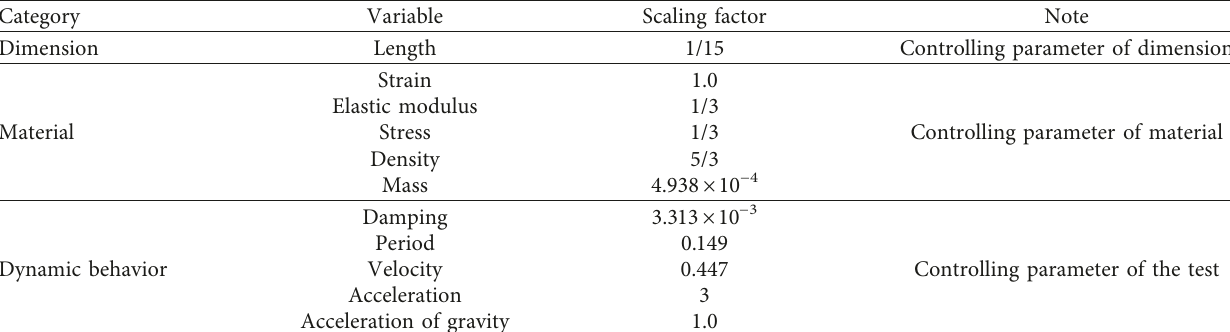
Table 8: Typical scaling factors for converting model response to full-size prototype